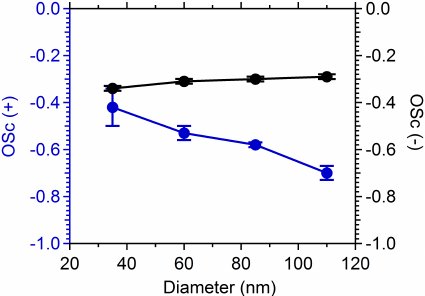
Figure 6. Average OSc vs. particle diameter for monomer species (fewer than 10 carbon atoms in the assigned formula) detected in positive ( + ) and negative ( − ) ion mass spectra. Error bars represent 1 standard deviation for five replicate